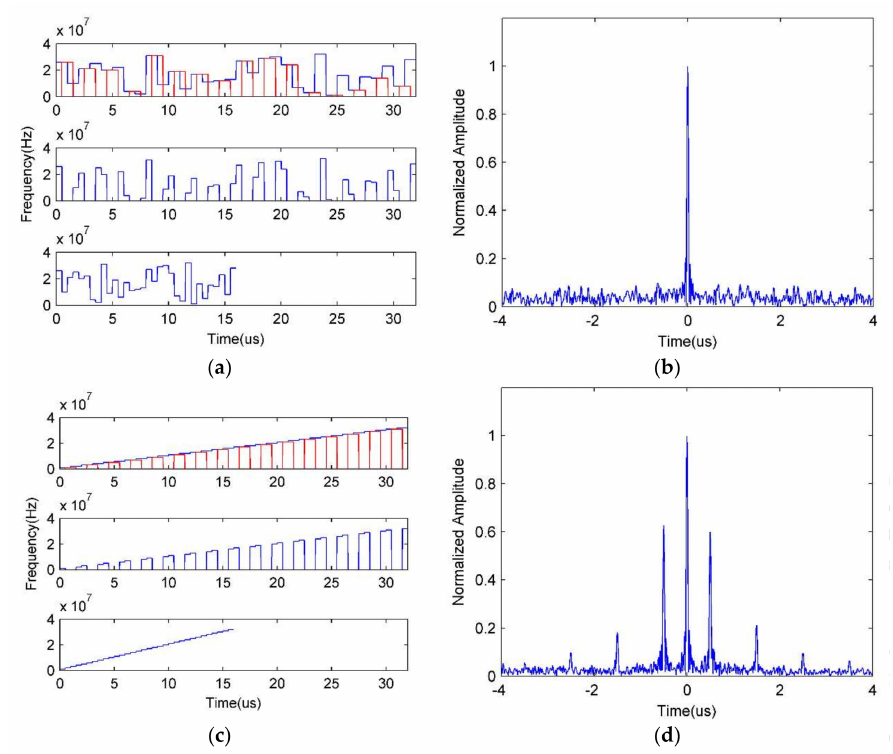
Figure 14. Simulation results of Approach II. ( a ) TF curves in different signal processing moments under IPFC signal; ( b ) the ISRJ suppression result under IPFC signal; ( c ) TF curves in different signal processing moments under stepped-frequency signal; ( d ) the ISRJ suppression result under stepped-frequency